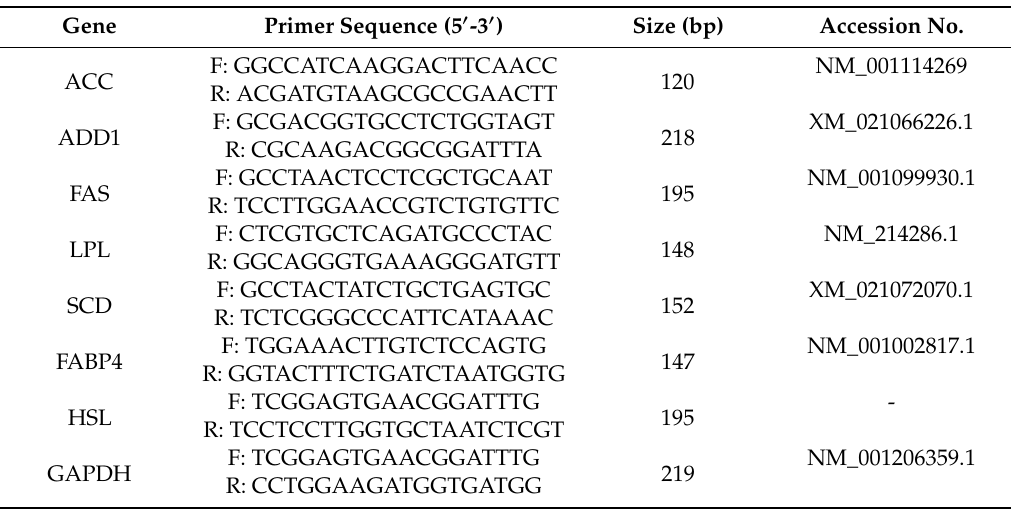
Table 2. Primers used for real-time quantitative PCR in this